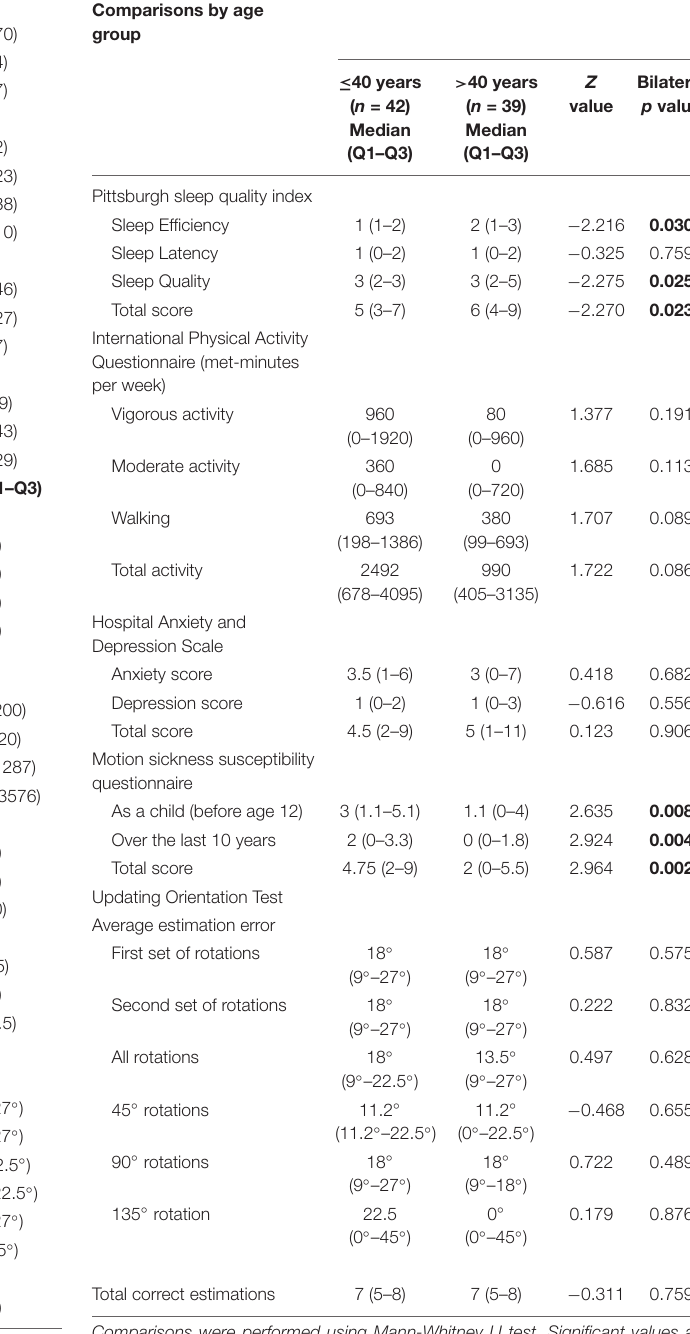
TABLE 1 | General characteristics and questionnaire scores of the 81 adults participating in the study.